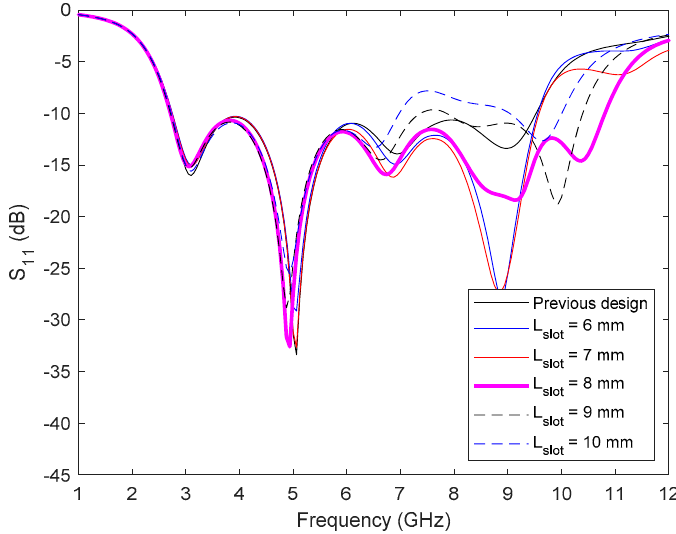
Figure 6. Antenna reflection coefficient for different slot lengths ( L slot ).